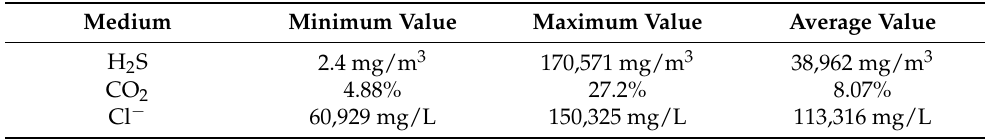
Table 1. The content of the corrosion medium in the field.